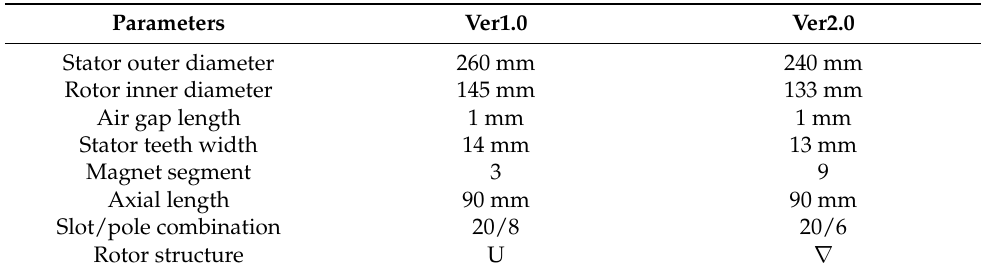
Table 7. Ver2.0 motor’s main size and structure.